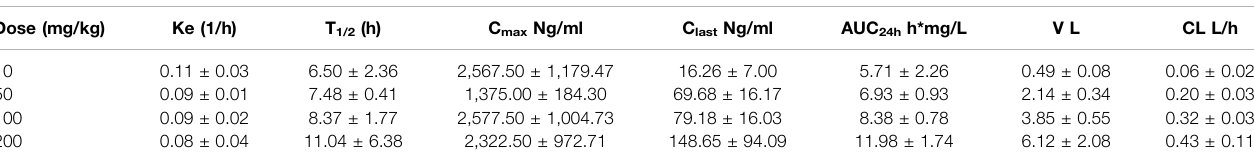
TABLE 2 | Pharmacokinetic values of 25 – 106 in